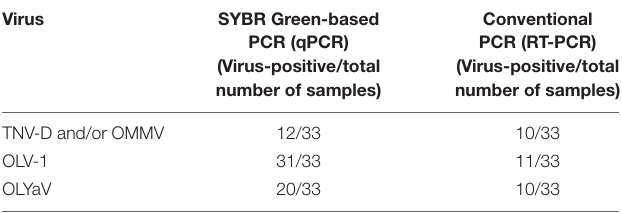
TABLE 5 | Comparison of SYBR R (cid:13) Green-based real-time quantitative reverse transcription PCR assays with conventional PCR, for virus detection in field-collected samples from 11 olive orchards, in several regions of Tunisia.